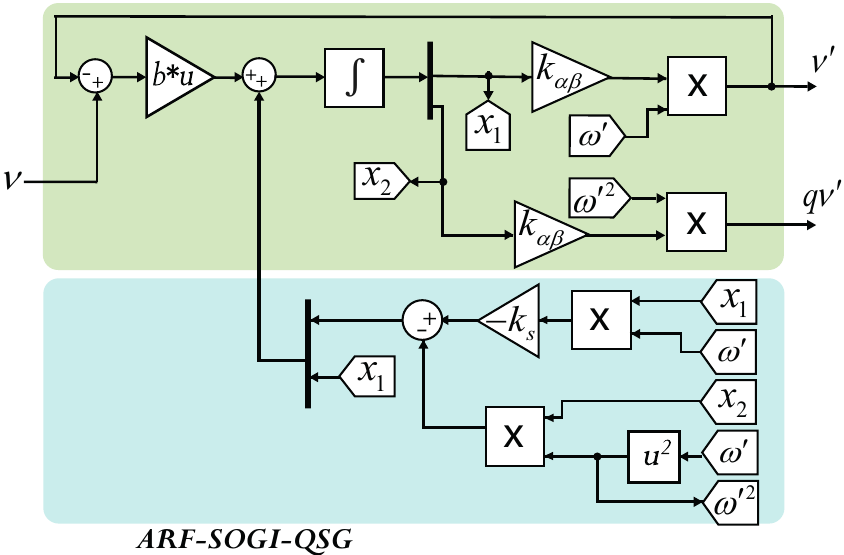
Figure 2. State space architecture of the